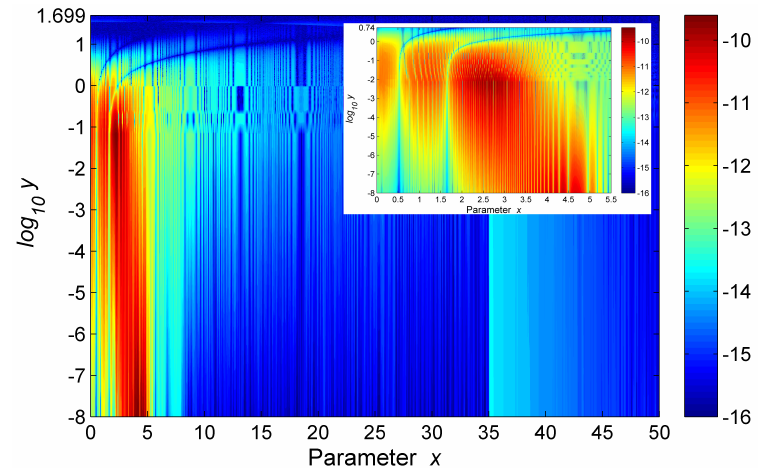
Figure 3. Relative error ∆ Re for the real part K ( x , y ) of the complex error function. Inset shows the relative error ∆ Re in the area near the origin.